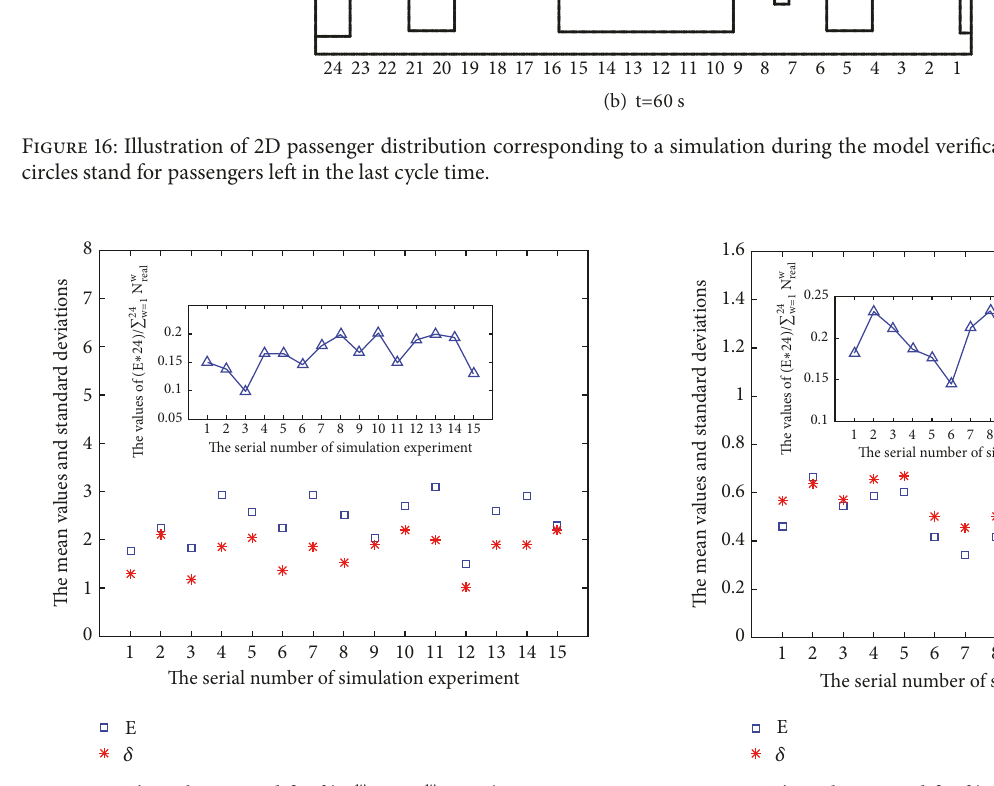
Figure 17: The values E and 𝛿 of |𝑁 𝑤 𝑟𝑒𝑎𝑙 − 𝑁 𝑤 𝑠𝑖𝑚𝑢𝑙𝑎𝑡𝑖𝑜𝑛 | at 24 waiting areas.